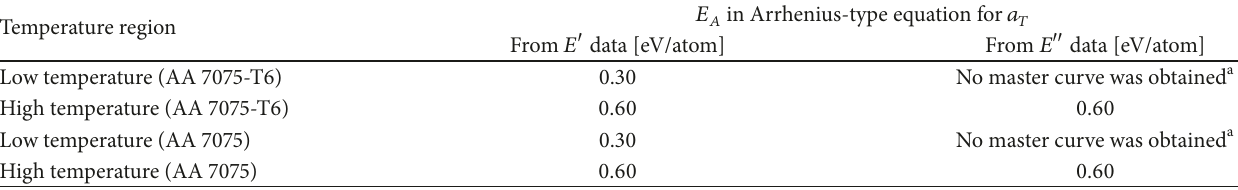
Table 3: Activation energy 𝐸 𝐴 in the Arrhenius-type equation for the shift factor 𝑎 𝑇 for Al–Zn–Mg alloys. Temperature region